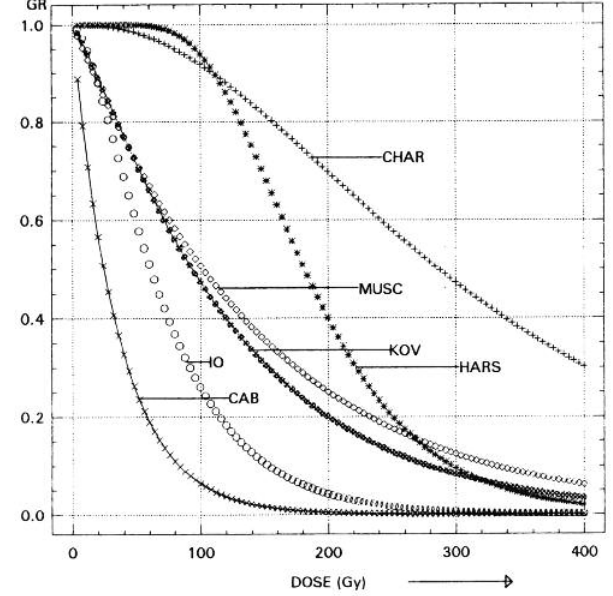
-ray sensitive at the studied vine varieties (clones) Fig. 4. Model of χ MUSC = Muscat ottonel clone type KOV = Kövidinka K.8 IO = Irsai Olivér K.11 CAB = Cabernet Sauvingon E.153 HARS = Hárslevelû K.9 CHAR = Chardonnay clone